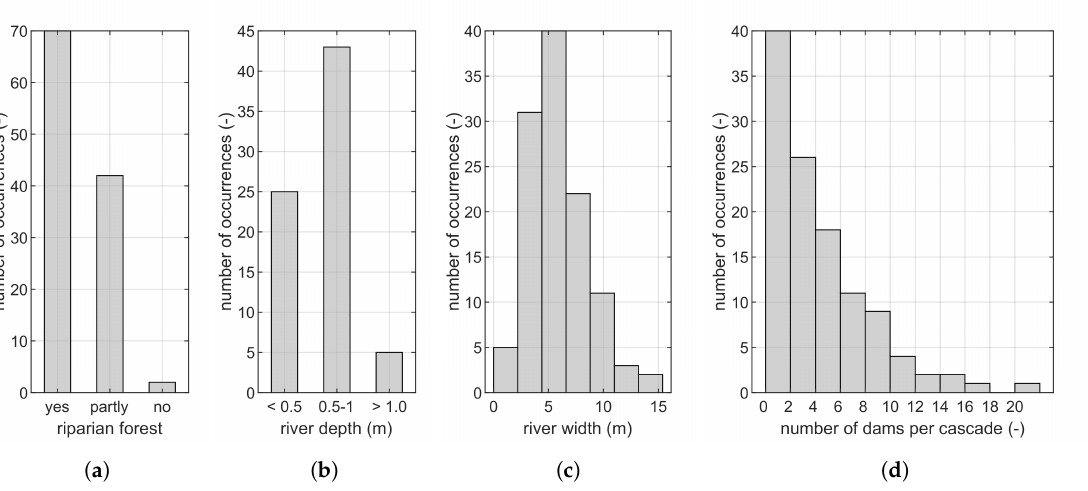
Figure 3. Frequency distributions of characteristic parameters in the surrounding of beaver dam cascades. ( a ) occurrence of forest at the river borders, ( b ) river depth, ( c ) river width, and ( d ) amount of dams per